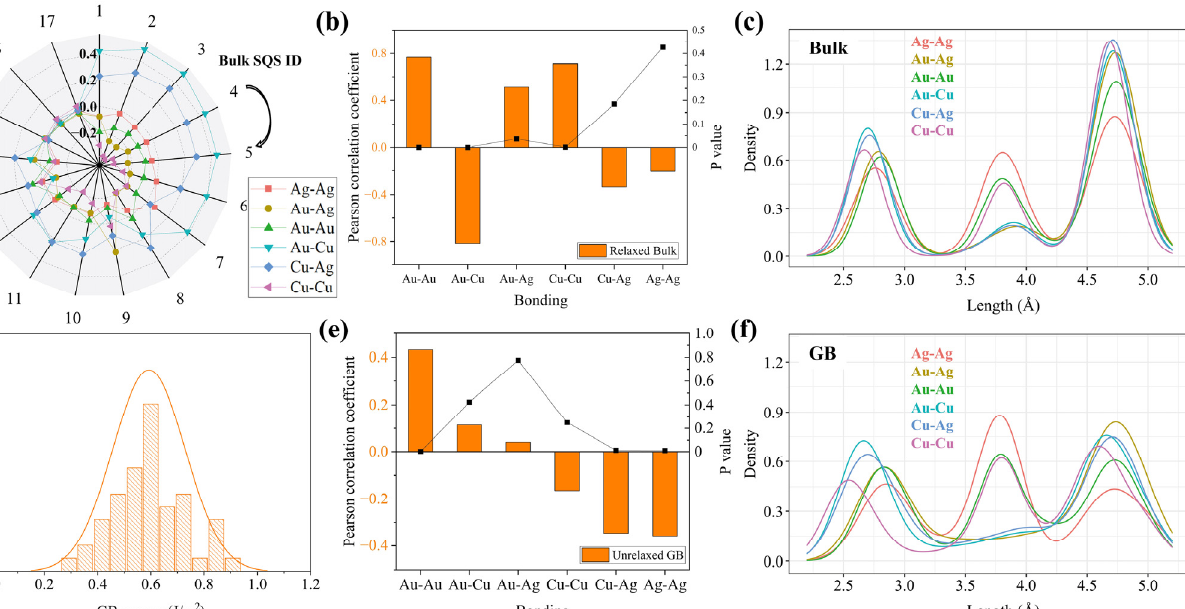
Figure 5. Schematic of one disordered bulk supercell and three GB supercells obtained by rotation.